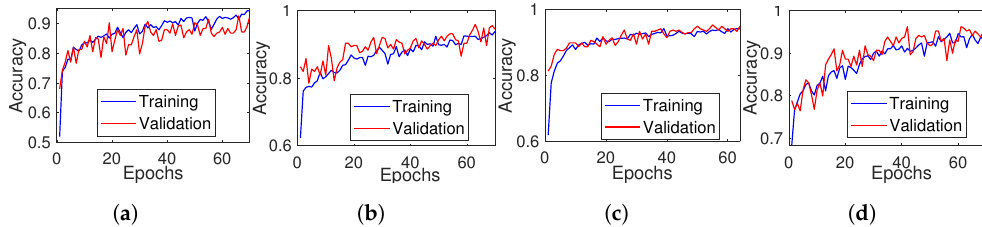
Figure 9. Models accuracy on nutrient deficiency classification. ( a ) ANN accuracy. ( b ) CNN accuracy. ( c ) MobileNetV2 accuracy. ( d ) VGG16 accuracy.